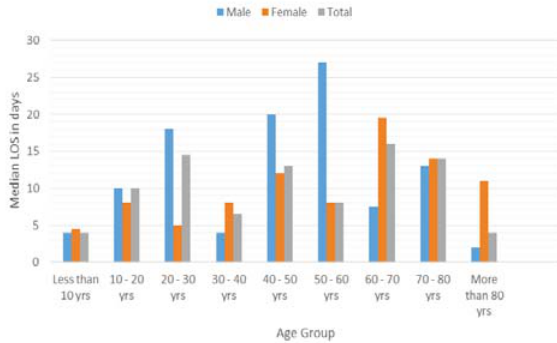
Figure 4. Median Length of Hospital Stay (LOS) in (cid:71)(cid:76)(cid:3445)(cid:72)(cid:85)(cid:72)(cid:81)(cid:87)(cid:3)(cid:68)(cid:74)(cid:72)(cid:3)(cid:74)(cid:85)(cid:82)(cid:88)(cid:83)(cid:86)(cid:3)(cid:3) Characteristic of the Burns Flame burn was the most frequent cause of burns (41%) closely followed by scalds (40%). Other etiological factors were electric burn (16%) and acid burn (3%) in the descending order of frequency. Distribution of various causes of burns in various age-groups can be seen in Figure 5 .